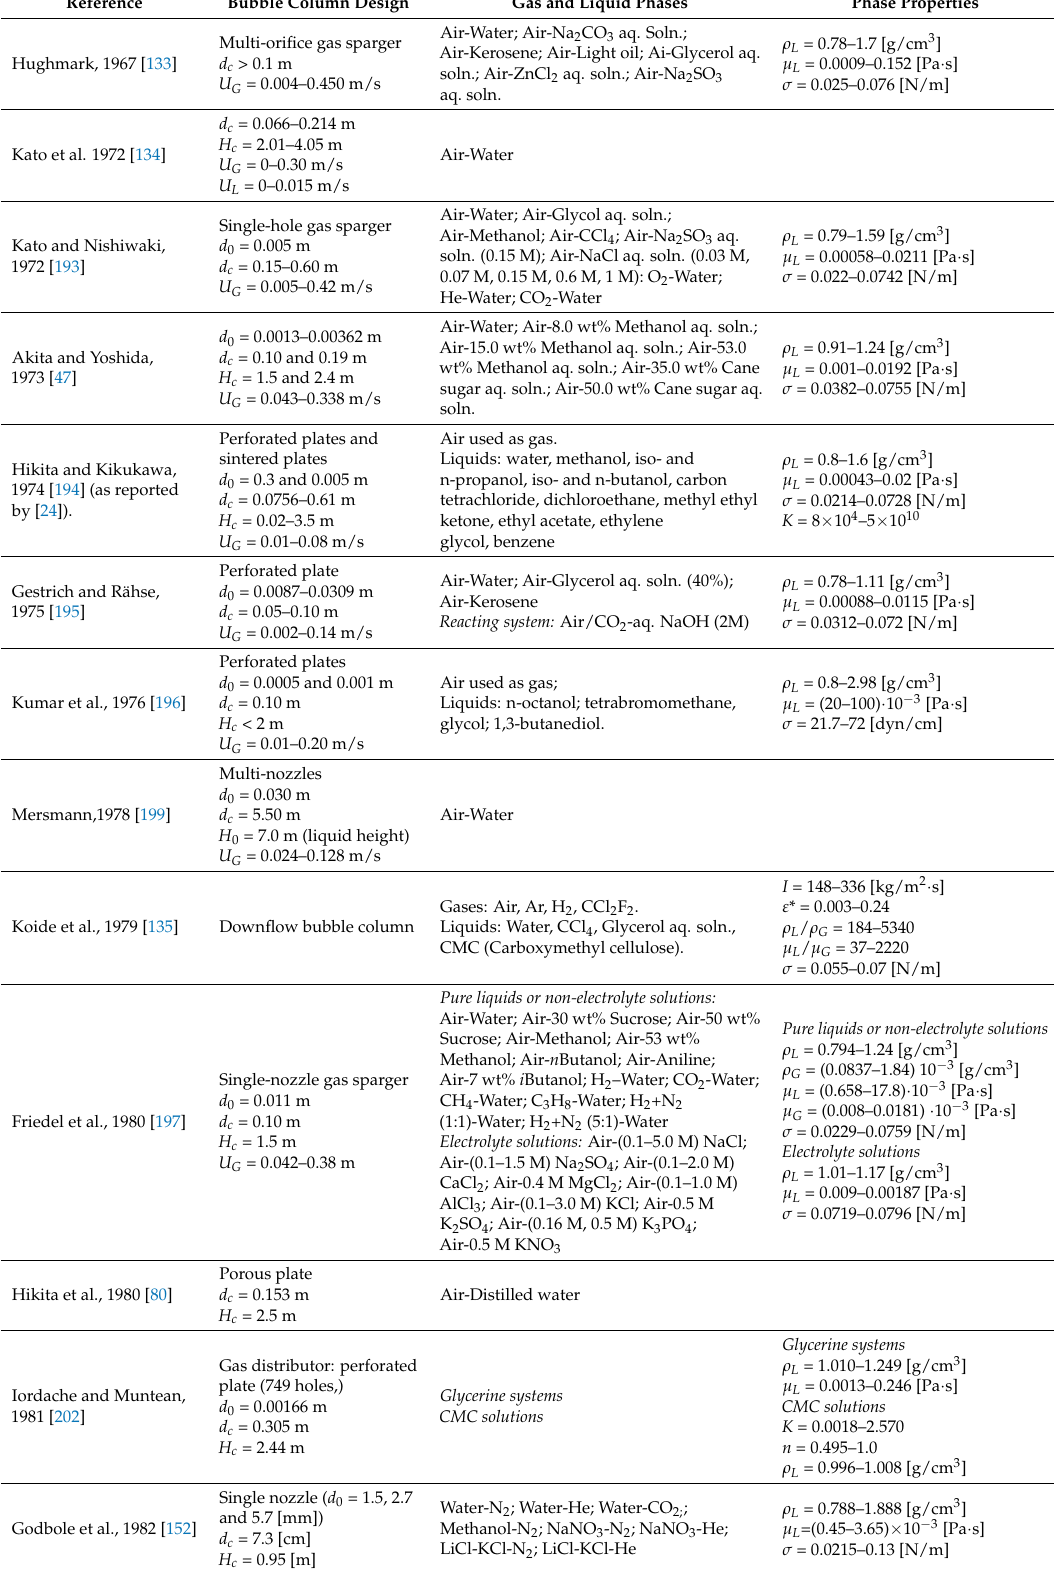
Table 4. Gas dholdup